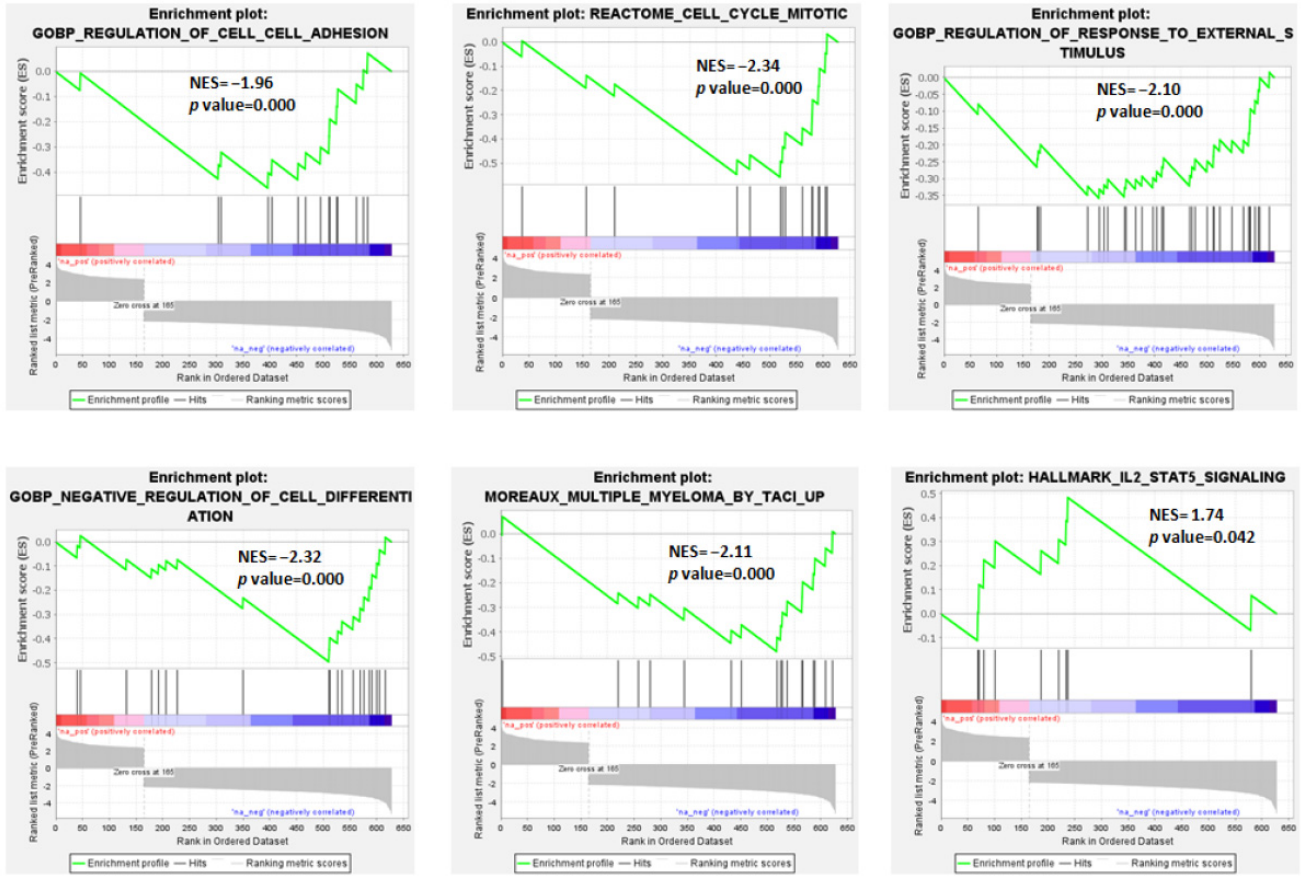
Figure 2. Enrichment plots of 6 selected gene sets detected by GSEA. The green curves show the enrichment score and reflect the degree to which each gene (black vertical lines) is represented in the ranked gene list. NES: Normalized Enrichment Score.